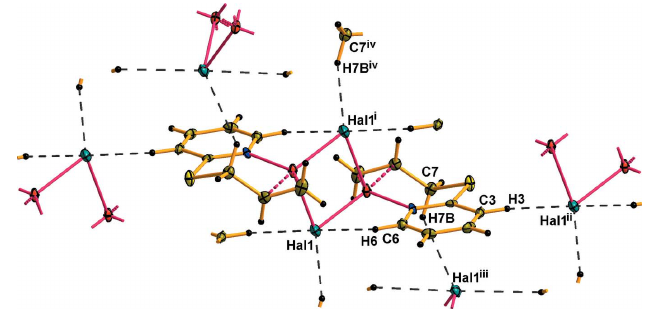
Figure 3 Fragment of the extended structure of I with hydrogen bonds shown as dashed lines. Symmetry codes: (i) (cid:3) x + 1, (cid:3) y + 1, (cid:3) z + 1; (ii) x + 1, y , z ; (iii) (cid:3) x + 1, y + 1 , (cid:3) z + 1 ; (iv) x , (cid:3) y + 3 , (cid:3) z + 1 . The packing for II is 2 2 2 2 essentially